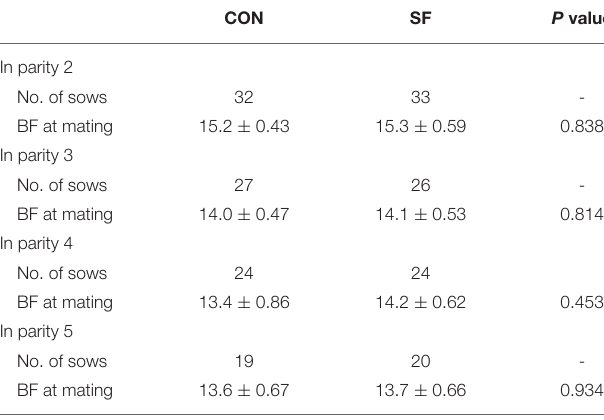
TABLE 4 | Backfat thickness of sows at mating at each parity a